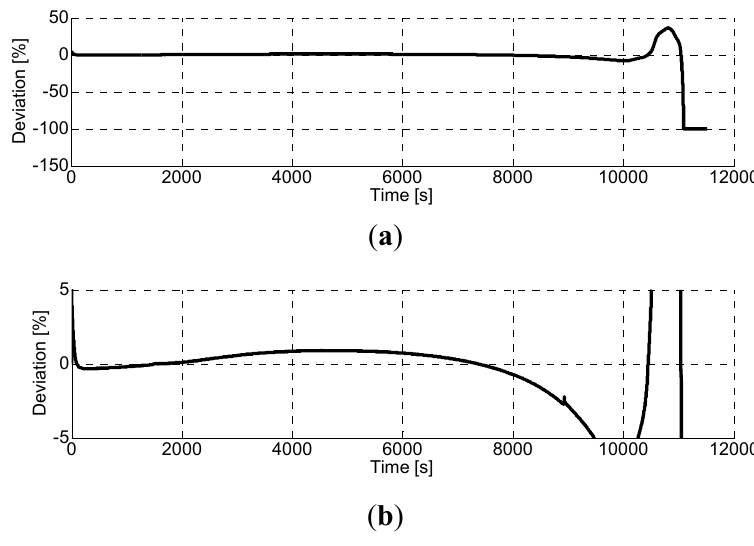
Figure 5. Relative deviation among measured data and model output (simplified procedure). ( a ) Discharge characteristic: Simplified procedure; ( b ) Zoom of Figure 5a.